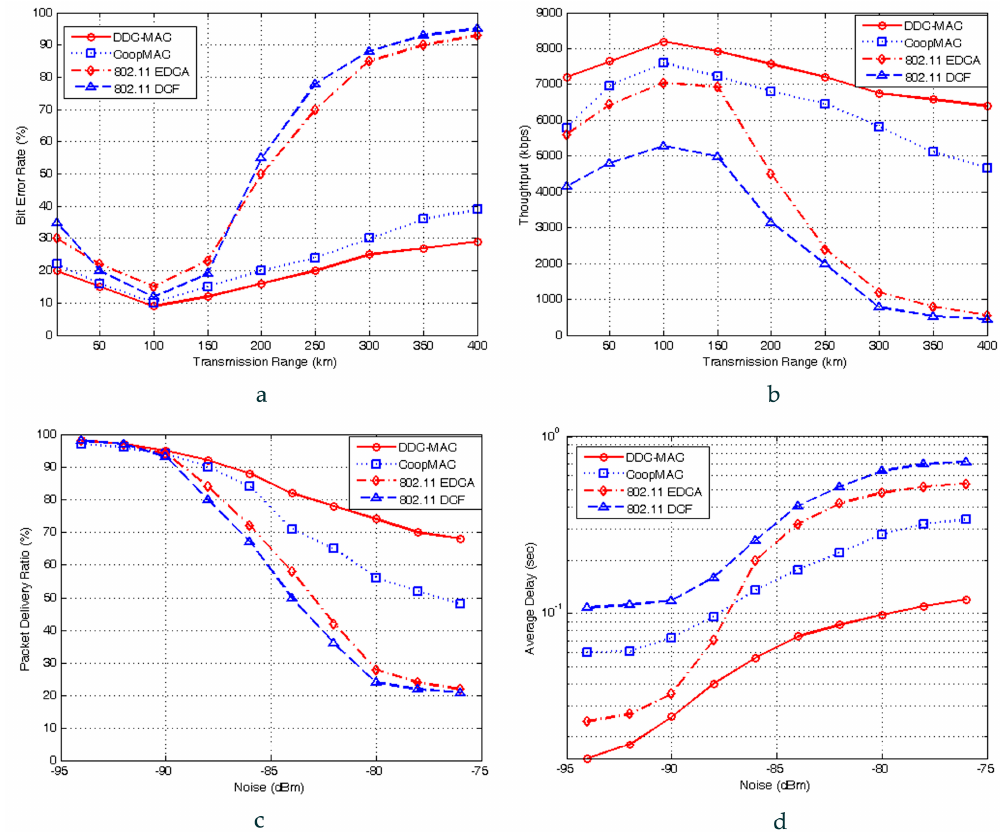
Figure 11. Impacts of transmission range and link quality on MAC performances with 2-hop optimal relay. ( a ) Transmission distance vs. bit error ratio; ( b ) transmission distance vs. throughput; ( c ) packet delivery ratio vs. link quality; ( d ) average delay vs. link quality